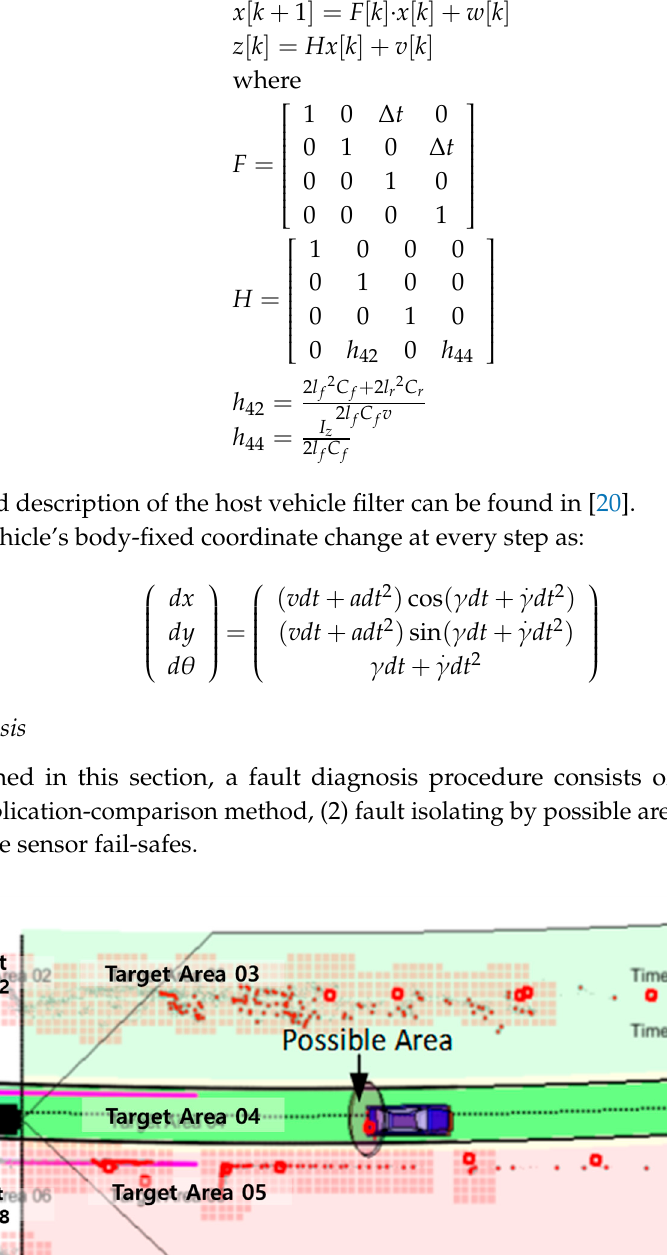
Figure 7. Modified duplication-comparison method. 3.5.2. Fault Isolation In Bader’s work [9], location of the fault was identified by comparing residuals from each branch. However, it is hard to isolate faults with a target-tracking filter because not only is it more complicated but also the filter selects the most relevant measurements based on the residual—i.e., the measurement that has low residual is selected in the track management phase. Therefore, faults are identified by using possible area in this paper. As illustrated in Figure 8, if the sensor’s measurements that are not measured within the possible area, the sensor is identified as a faulty sensor. 3.6. In-Vehicle Sensor Fail-Safes Since the wheel speed sensors and yaw rate sensor are used in this algorithm, their faulty behavior should also be detected. To assure the functional safety of in-vehicle sensors, the concept of hypothesis testing is used. The predicted future estimations of surrounding vehicles are stuck at every iteration. Originally, they are almost the same since they estimate the same vehicle at specific time. However, because they are rotated and transferred every step as the host vehicle moves, the last estimations would be far different from the others when one of those sensors malfunctions. Therefore, the assumption is that the standard deviation of the saved estimations is small only when the in-vehicle sensors function normally.